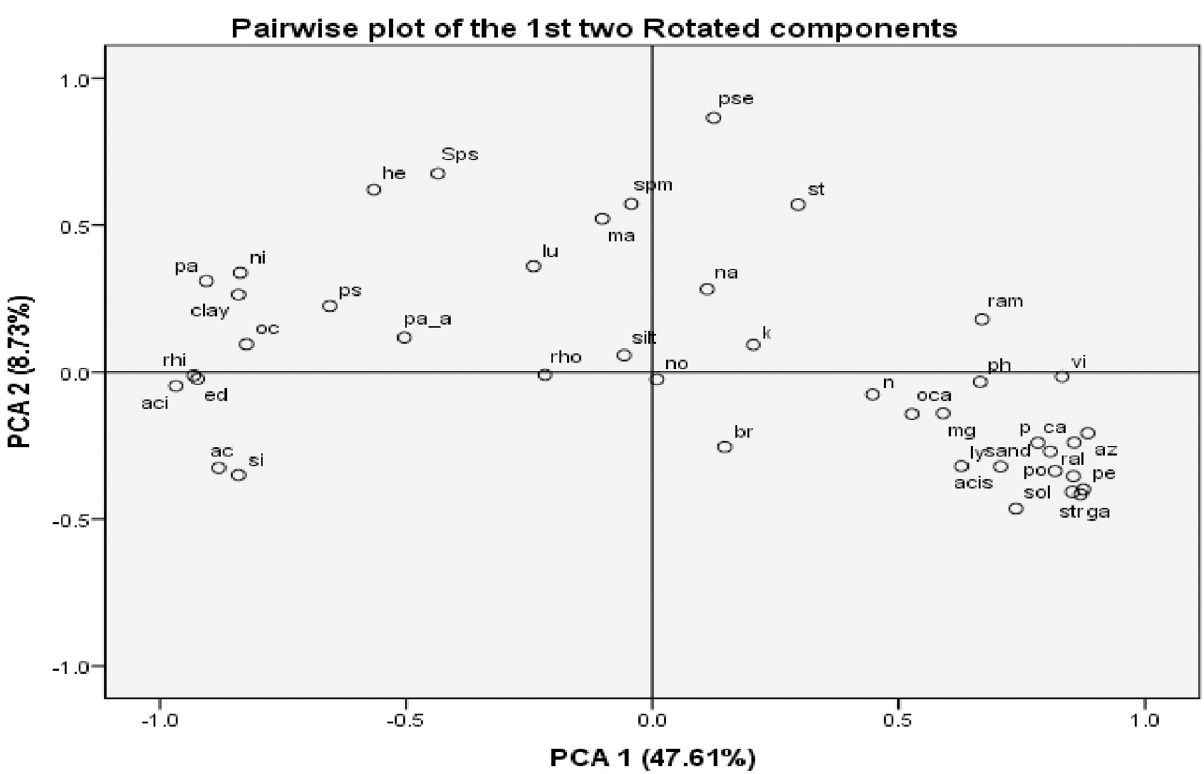
Fig 2. Plot of correlated variables by PCA1 and PCA2 (sps- Sphingomonas, ac- Acidibacter, lu- Luteimonas, ly- Lysobacter, ps-Pseudomonas, po- Povalibacter, ral- Ralstonia, ram- Ramlibacter, he- Herbaspirillum, ma- Massilia, ni- Nitrosospira, az- Azoarcus, rhi- Rhizomicrobium, rho- Rhodoplanes, pe-pedomicrobium, spm- Sphingobium, aci- Acidobacterium, ed- Edaphobacter, si- Silvibacterium, oc- Occallatibacter, pa- Paludibaculum, st- Stenotrophobacter, br- Brevitalea, vi- Vicinamibacter, acis- Aciditerrimonas, pse- Pseudarthrobacter, no- Nocardioides, str- Streptomyces, ga- Gaiella, pa_a- Patulibacter, sol- Solirubrobacter, ph-PH, na-Na (sodium), ca-Ca (calcium), mg-Mg (Magnesium),